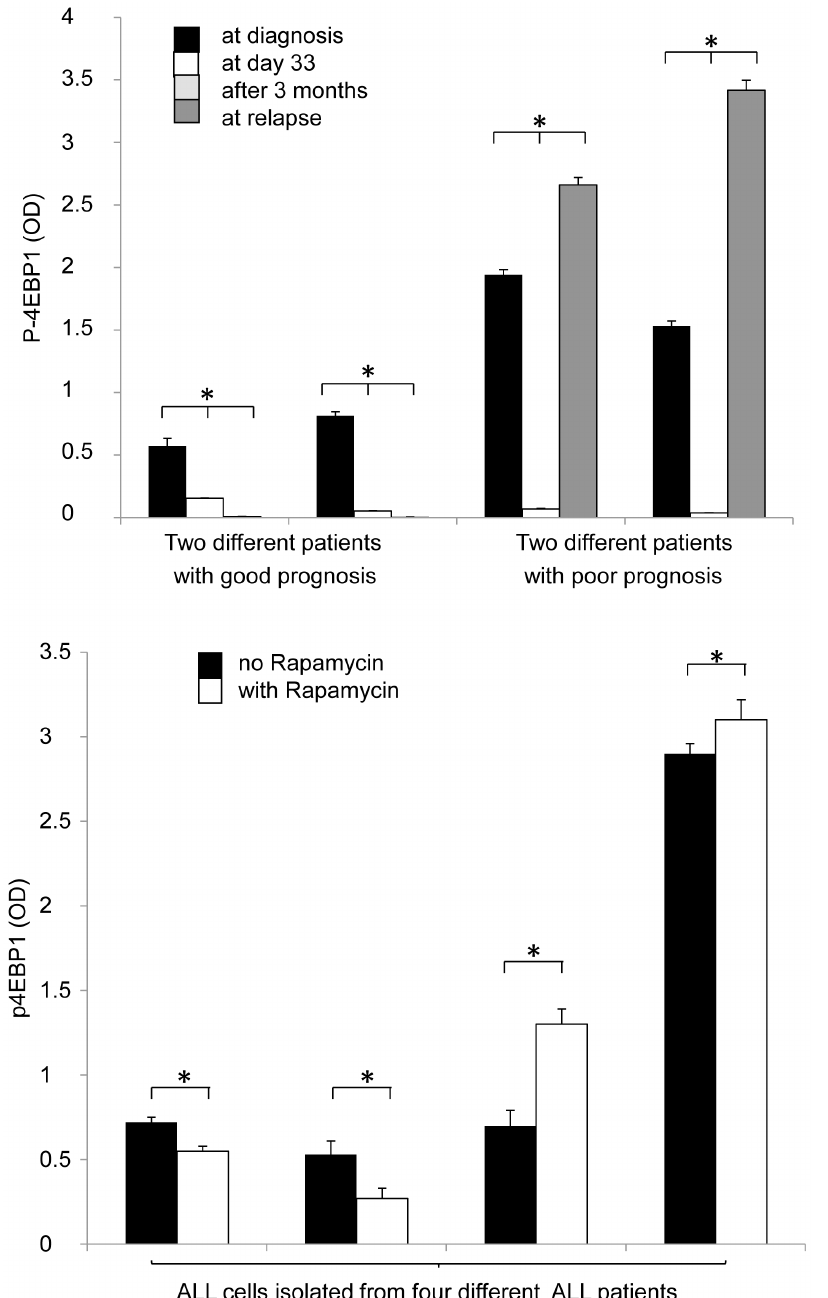
Figure 4. Changes in mTOR related p-4EBP1 expression in samples of ALL patients after invivo chemotherapy and in cultured ALL cells treated with rapamycin invitro . (a) P-4EBP1 OD is reduced by chemotherapy, but re-increases during relapse in ALL patient samples. Data is shown from 2 representative patients with good prognosis and 2 patients with poor prognosis at day 0, day 33, after three months of treatment, and at relapse (ELISA). (b) In vitro rapamycin sensitivity is variable in different human ALL samples (n=4). P-4EBP1 levels variably decrease or increase after in vitro rapamycin treatment (50 ng/ml, 24 h) in isolated ALL cells (ELISA). A decrease in p-4EBP1 was associated with concomitant induction of apoptosis by rapamycin ( . 50% apoptotic cells in the first two samples; data not shown). (The first three samples were cultured from cells isolated from primary ALL cases and one at relapse.) *- P , 0.05. doi:10.1371/journal.pone.0059335.g004 (Fig. 5a) and Jurkat cells. However, Mn60 and CEM cells were less The effect of rapamycin and chemotherapeutic drugs was sensitive to combination treatment. Rapamycin enhanced apo- variable in BMMNC isolated from ALL samples. In two patients ptosis induced by cytosine arabinoside, etoposide and methyl- (one primary and one relapsed), induction of apoptosis was not prednisolone in Mn60 cell cultures, whereas it promoted only the significant ( , l0%) by rapamycin and the combinations. In other effect of methyl-prednisolone in CEM cells in vitro. three cases (2 primary cases and one relapsed), apoptosis induction